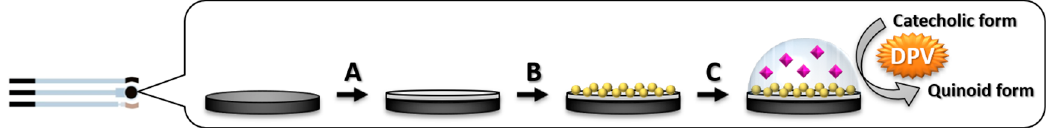
Figure 1. Scheme of the nanocomposite sensor for dopamine detection. ( A ) Electropolymerization of aniline using a 2.5 mM solution in 50 mM HClO 4 by cyclic voltammetry (potential range: from − 400 mV to +800 mV, scan rate: 50 mV/s, 10 cycles); ( B ) electrodeposition of gold nanoparticles using a 0.5 mM HAuCl 4 solution in 0.5 M H 2 SO 4 by cyclic voltammetry (potential range: from − 200 mV to +1200